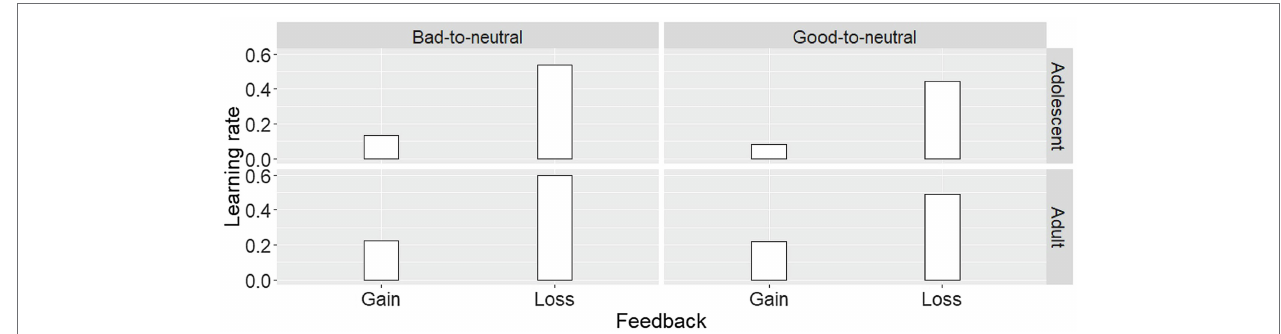
FIGURE 4 | Learning rates in the reinforcement learning model (RW_LG model). Participants had a higher learning rate when they received feedbacks representing loss money than that of gain money. Compared with the good-to-neutral partner, the learning rate to the bad-to-neutral partner was higher. Adults’ learning rate was higher than